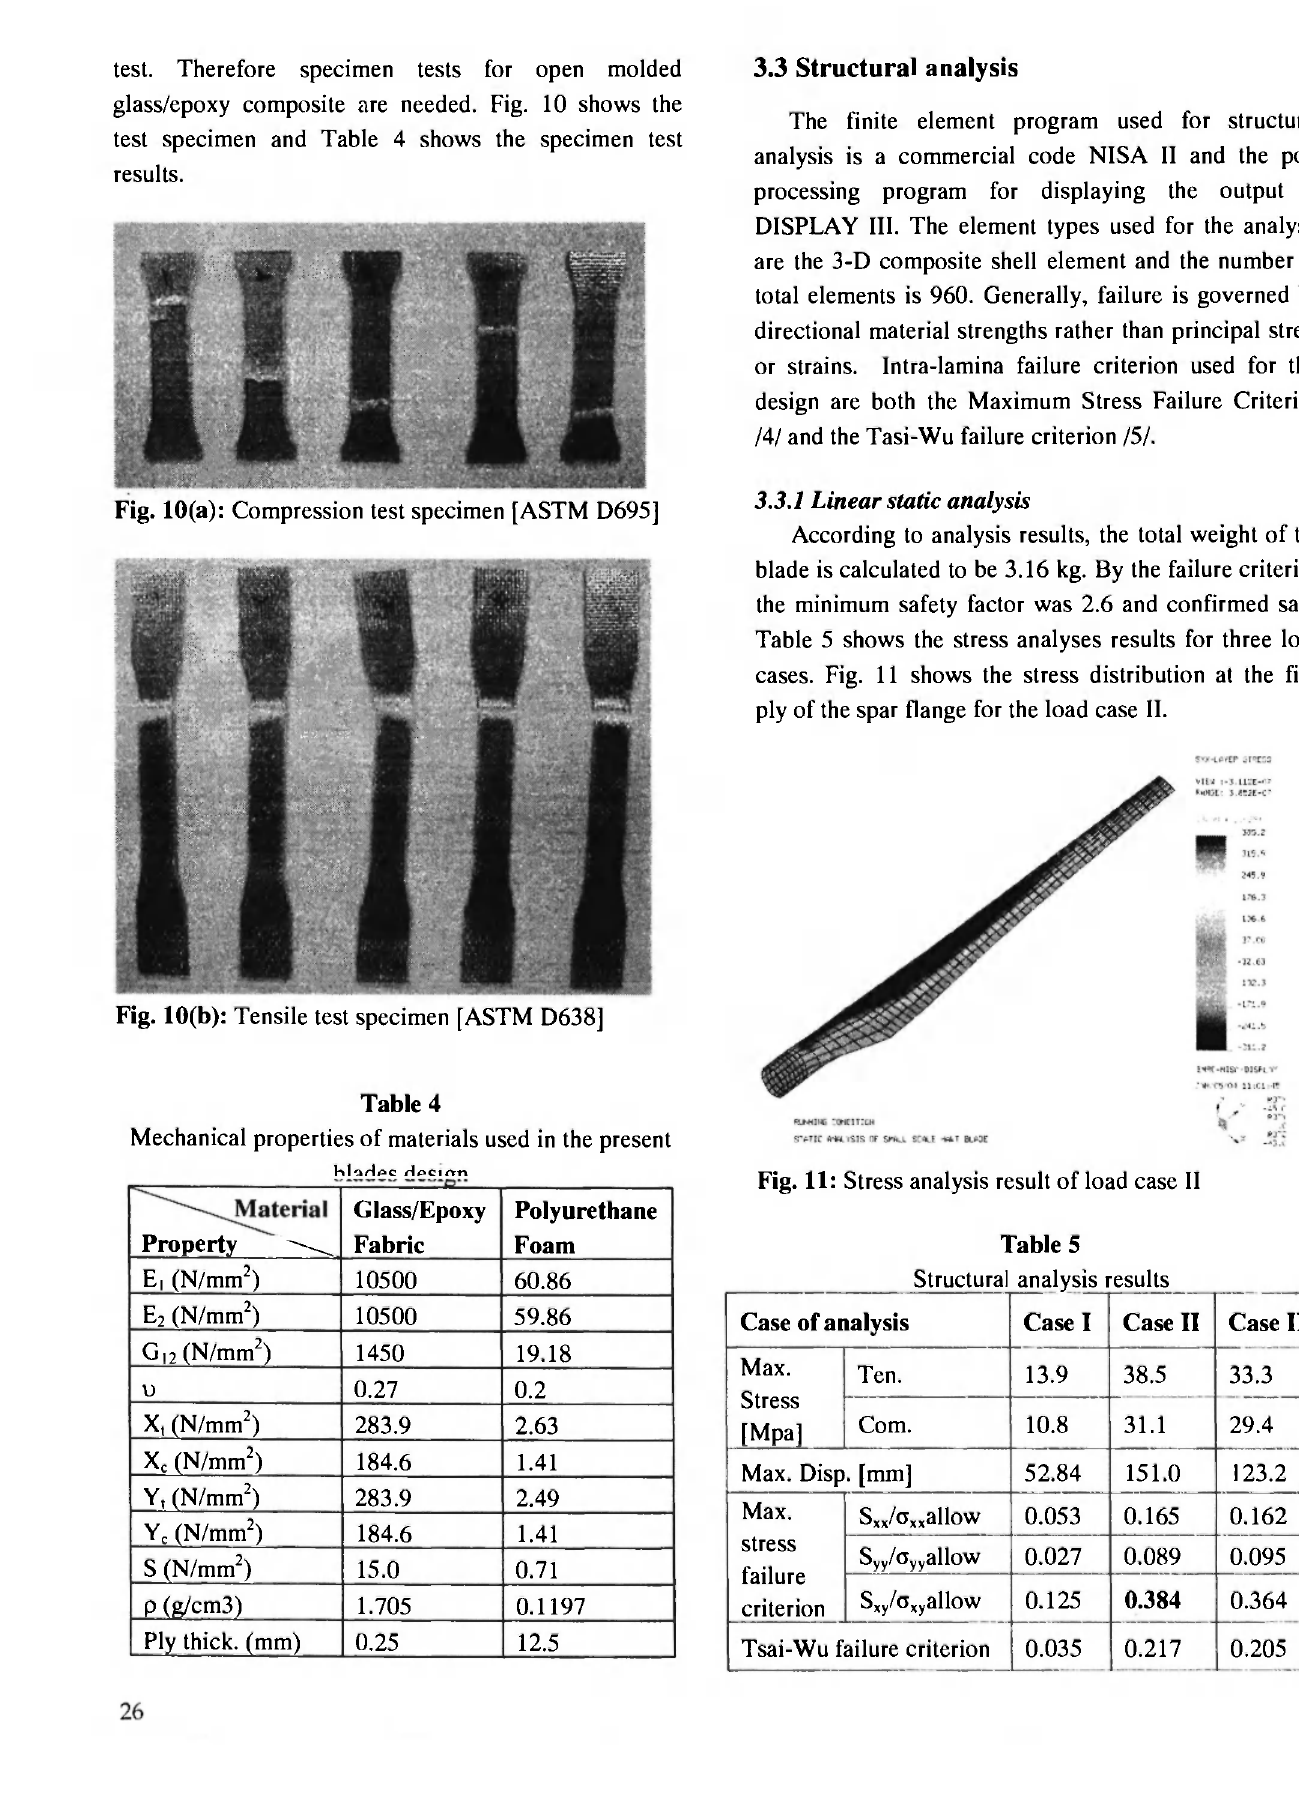
Fig. 11: Stress analysis result of load case